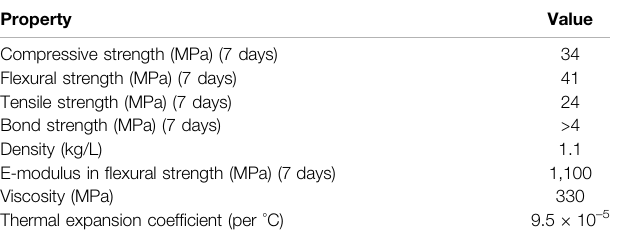
TABLE 4 | Properties of epoxy injection resin as provided by the manufacturer.